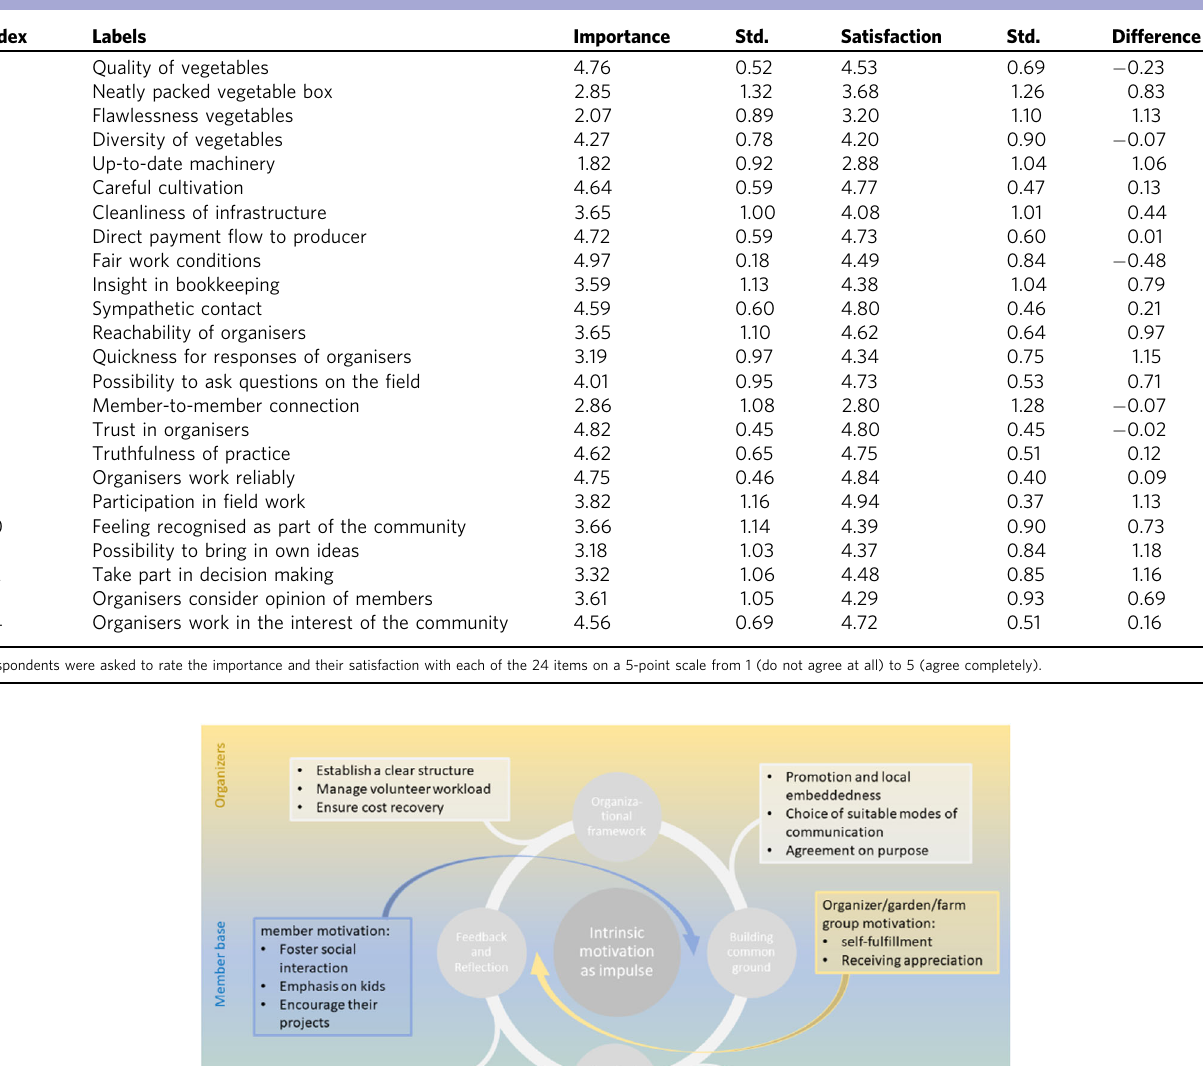
Table 3 Mean and standard deviations of the survey responses.